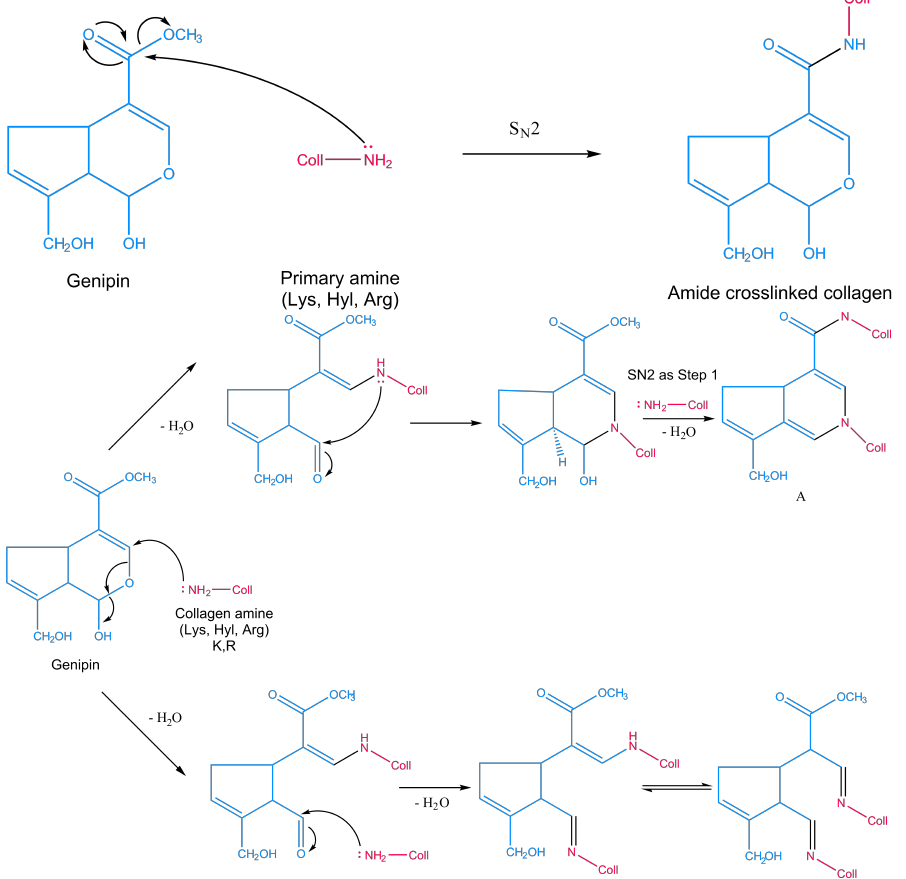
Figure 5. Crosslinking mechanism of genipin. First mechanism proposed in Butler et al. [30] Second proposed in Tambe et al. [31]. Image modified from Nair et al. [14] licensed under CC-BY